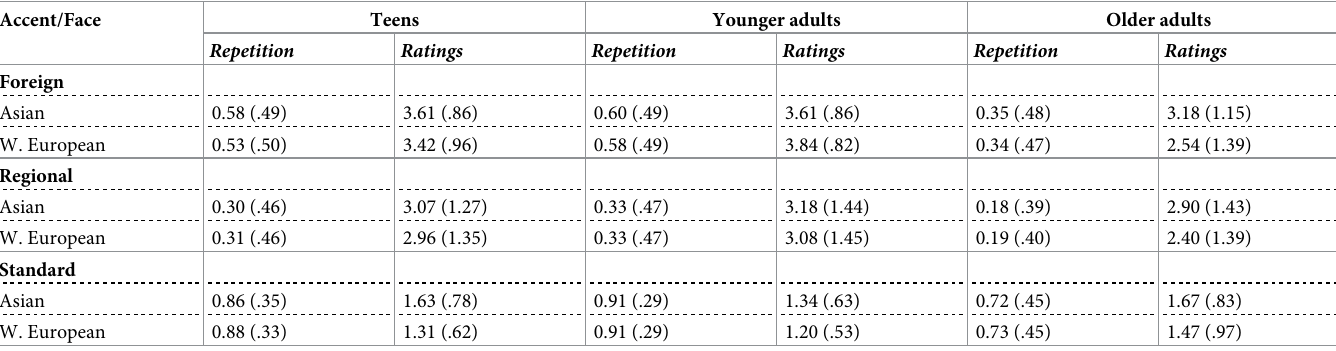
Table 1. Mean repetition accuracy and mean accentedness ratings.